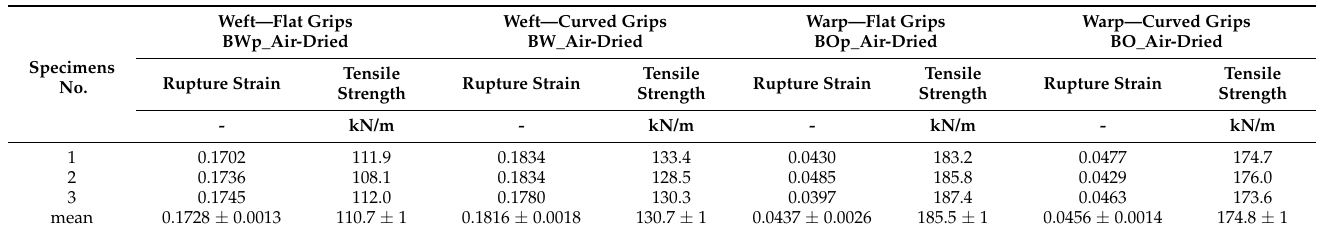
Table A6. Elongation at break and tensile strength—air-dried B type